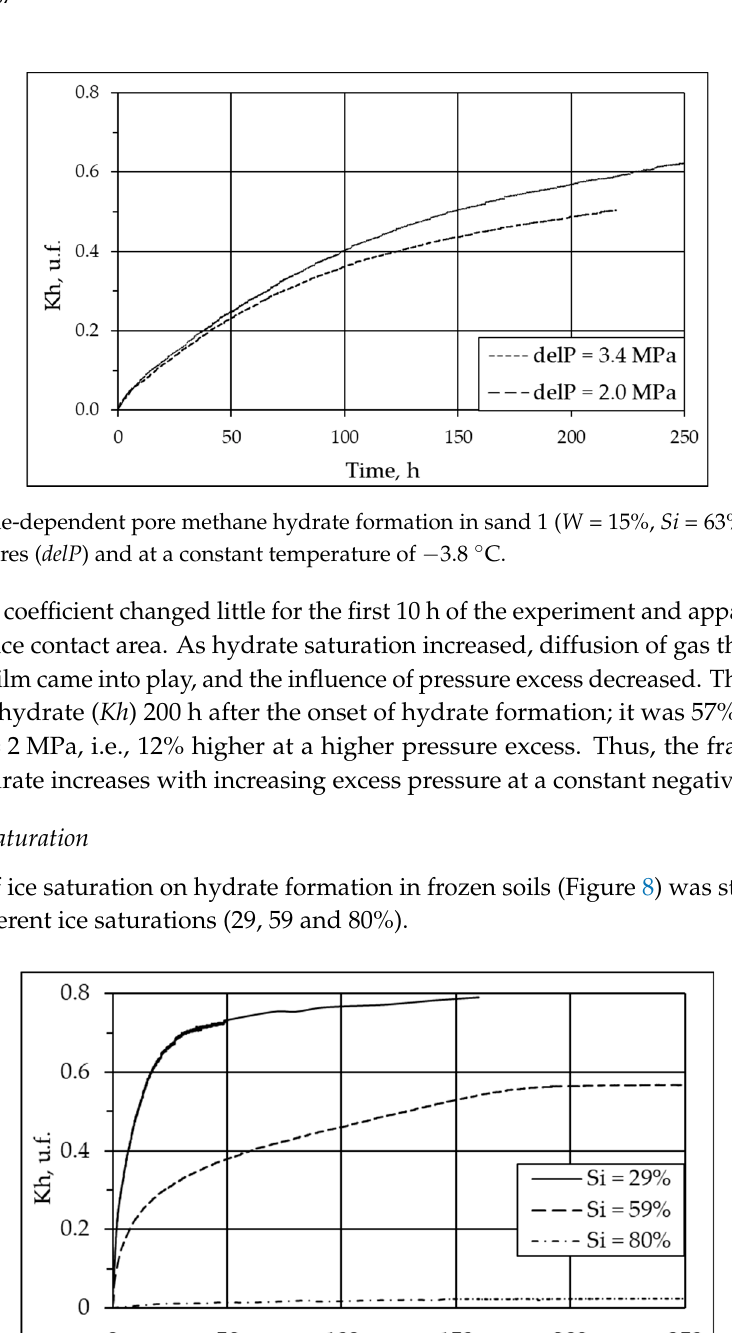
Table 3. Initial physical properties of frozen silt 2.